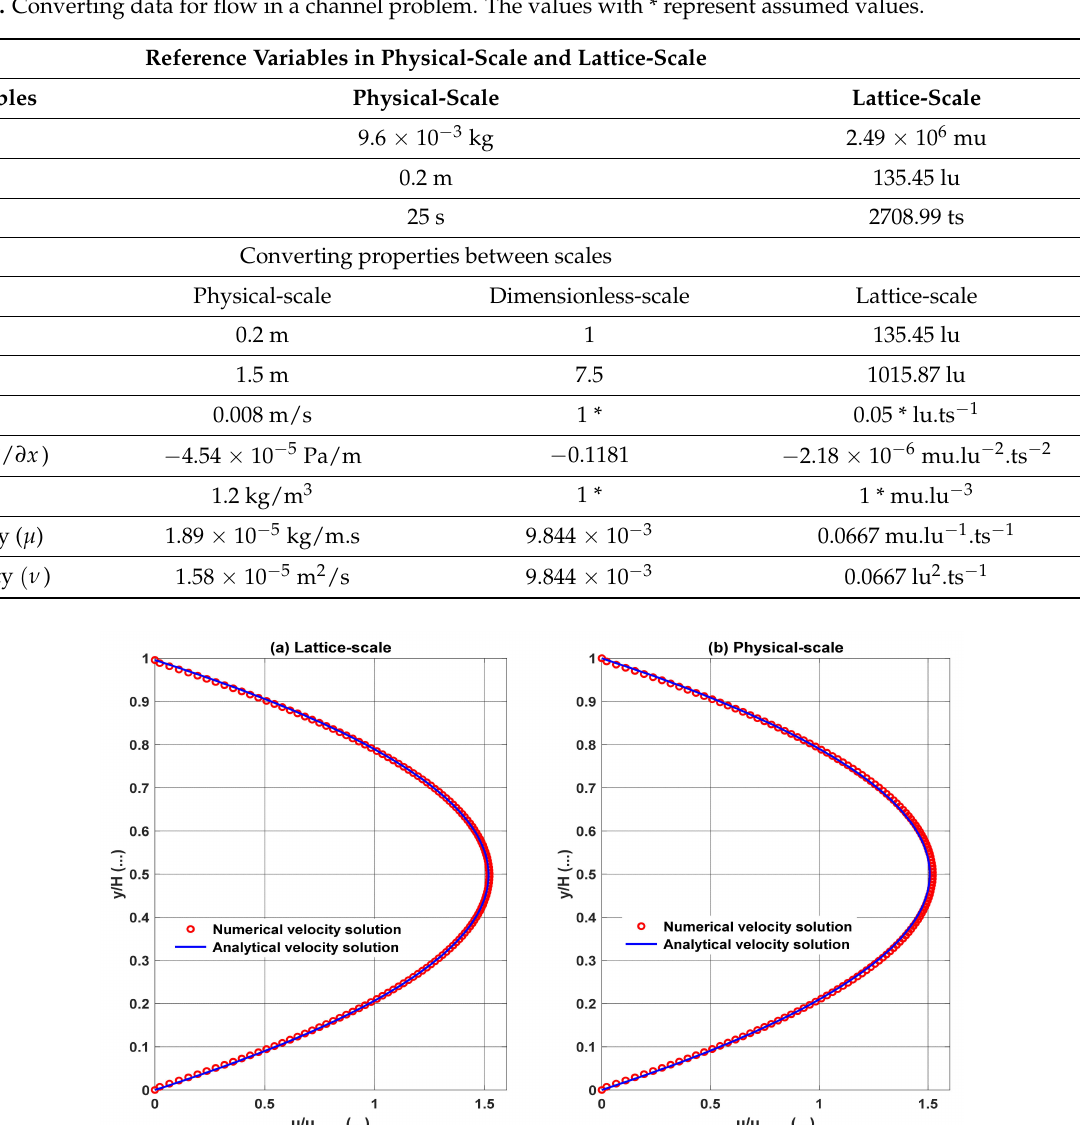
Figure 9. Fully developed velocity profile; ( a ) solutions at the lattice-scale, and ( b ) solutions at the